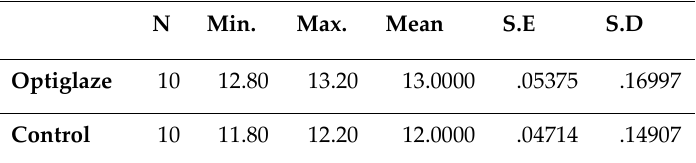
Table 2: Descriptive of sensitivity Test